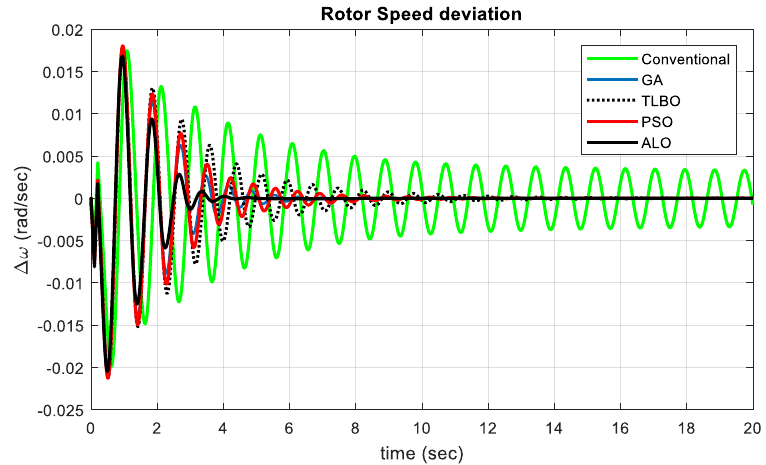
Figure 10. Rotor speed deviation of different algorithms with conventional fixed gain .